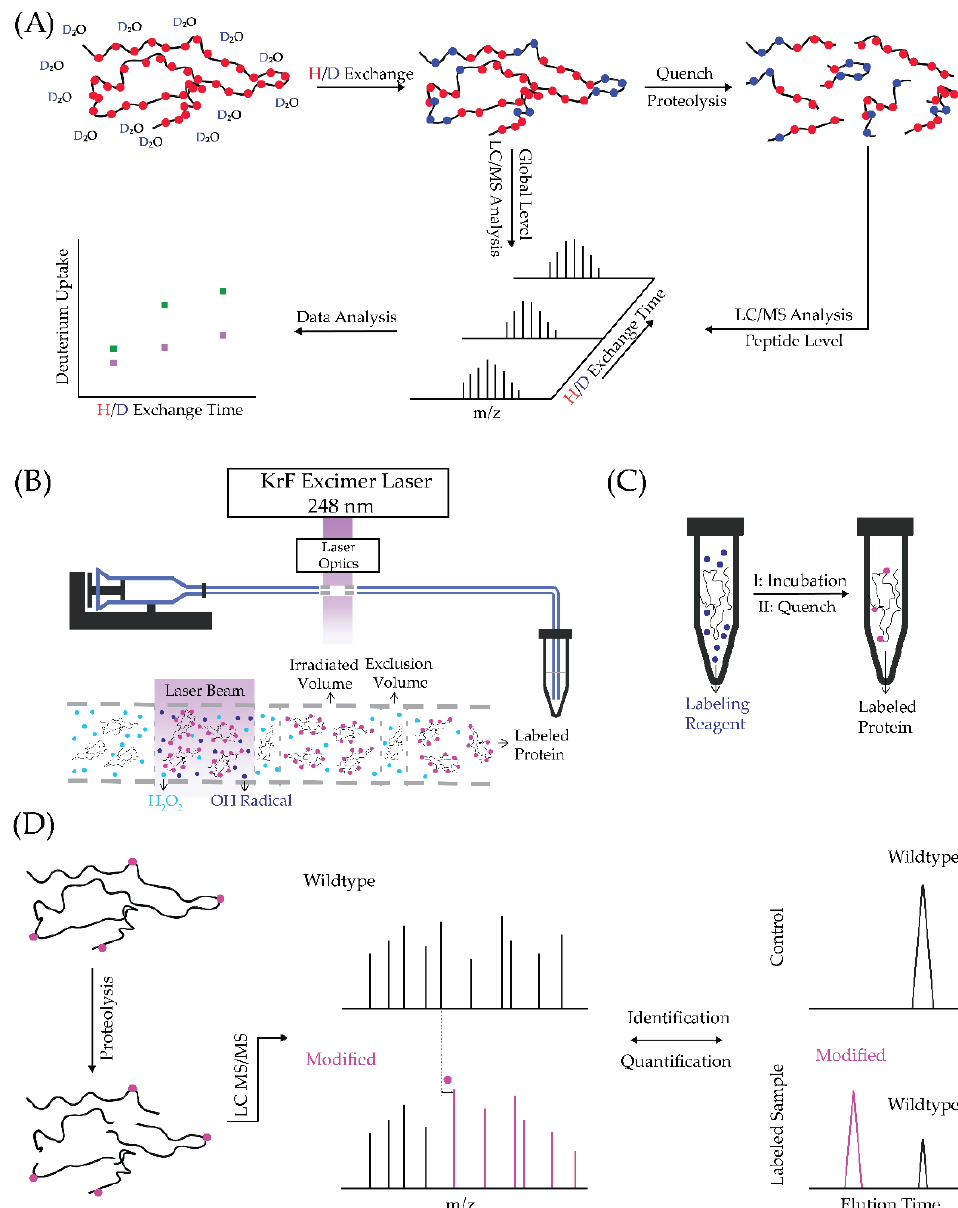
Figure 1. Schematic illustration of footprinting and bottom-up analysis workflow. ( A ) HDX: red dots represent protein backbone hydrogens; the green and purple squares in the deuterium uptake plot represent two different protein states. ( B ) FPOP: the laser window is shown as a grey dash line in the flow system; the zoom-in view of the laser window is shown below the flow set-up. ( C ) Specific amino-acid labeling. ( D ) Bottom-up analysis.